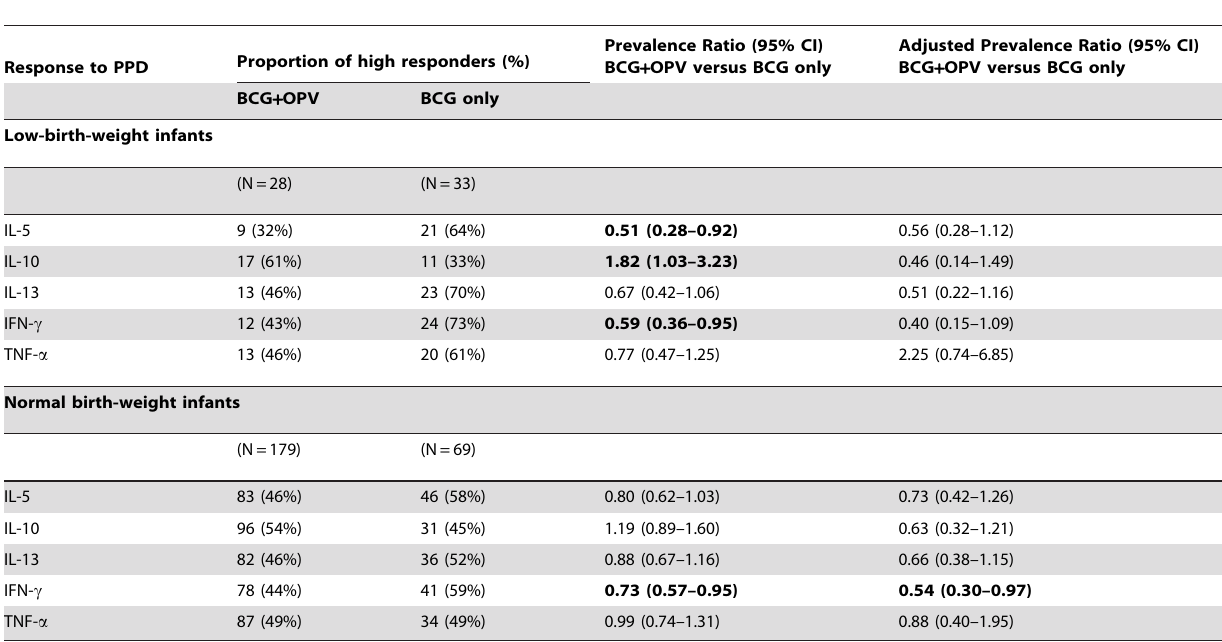
Table 3. Comparison of the frequency of cytokine responders in children vaccinated with BCG and with BCG + OPV.